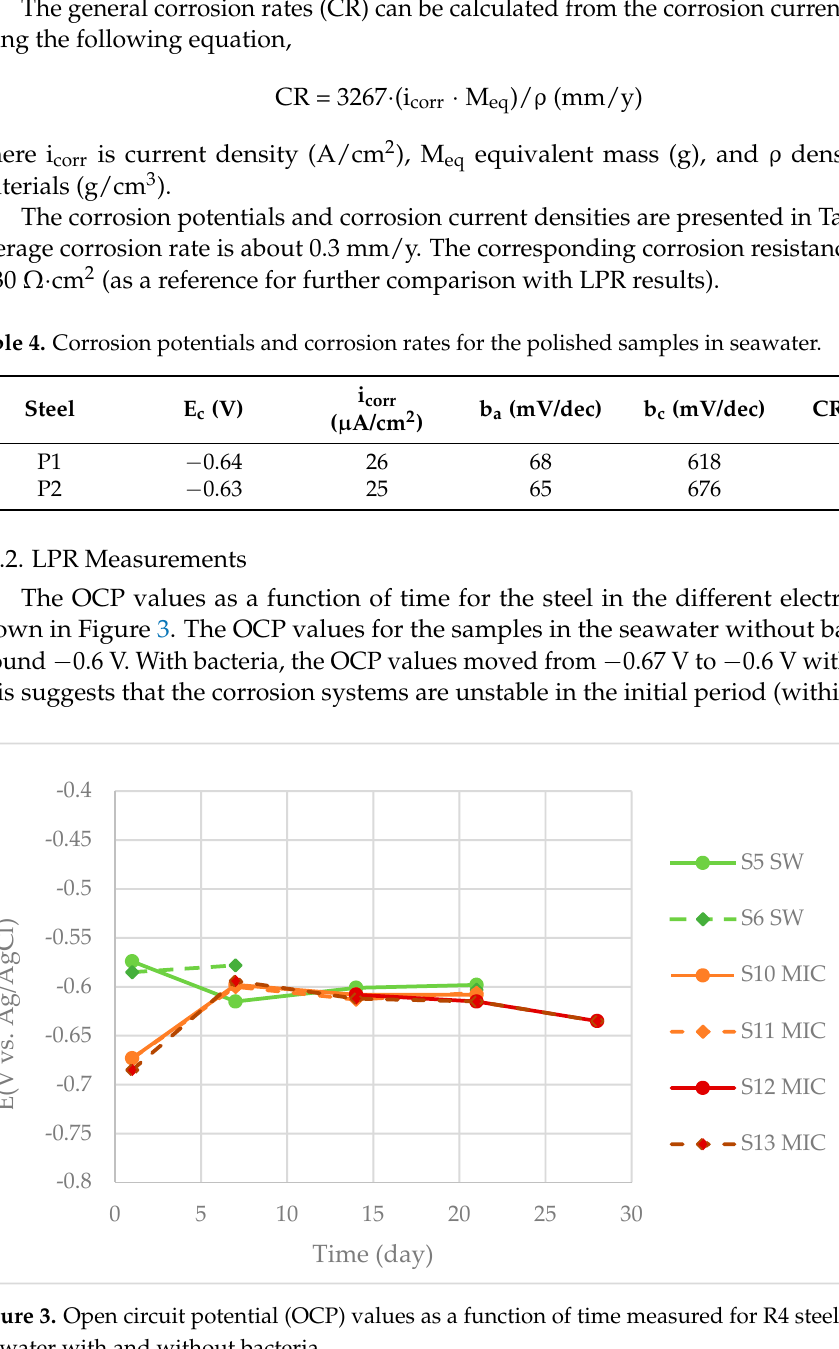
Table 4. Corrosion potentials and corrosion rates for the polished samples in seawater . Steel